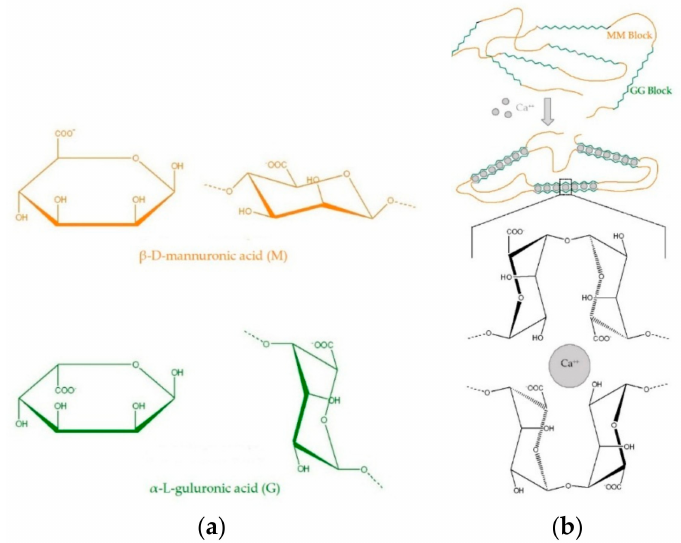
Figure 2. The structural formulae of monomeric units in alginate and the schematic representation of the egg-box model ( a ) Left hand side: Haworth conformation; right hand side: Chair conformation ( b ) Gelation of poly L-guluronate blocks (G Blocks, ) with Ca 2+ ( ) (Peteiro [32], Lee and Rogers